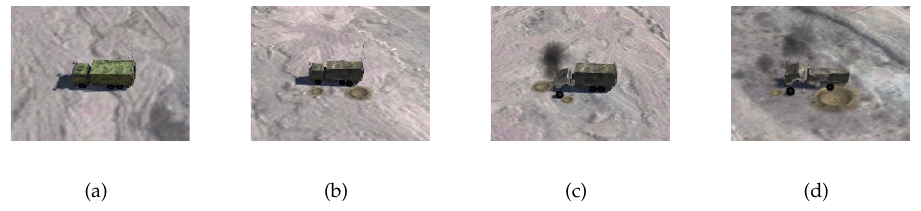
Figure 2. Supply vehicles with different damage levels. From ( a – d ), the damage levels of supply vehicles are normal, slightly damaged, functionally damaged, and severely damaged,